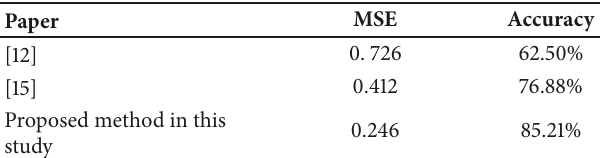
Table 7: The comparison of MSE and